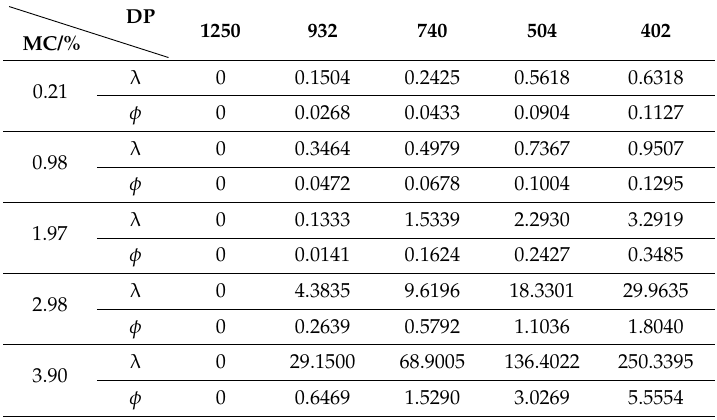
Table 5. Aging compensation factor φ form set A~E.